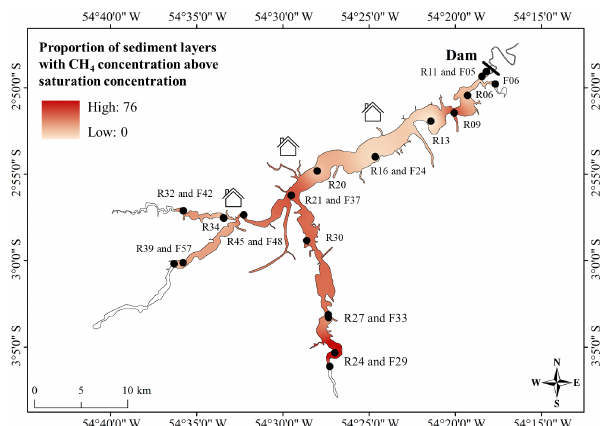
Figure 4. Percentage of sediment layers with CH 4 concentration above saturation. The black dots represent the sampling sites to pro- duce the interpolation. The houses represent the settlements at the